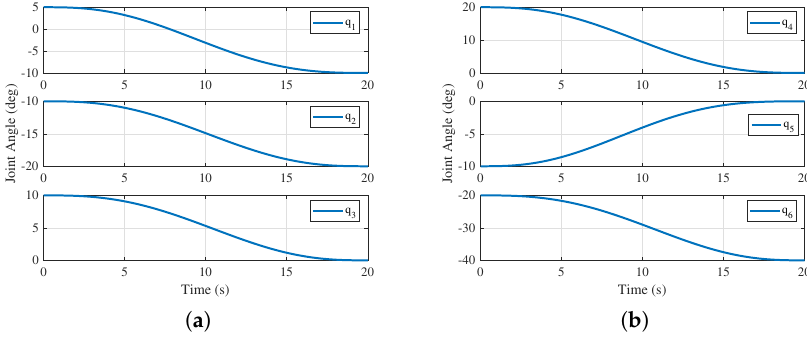
Figure 10. Angular variation curves of i th joint, where ( a ) i = 1, 2, 3, and ( b ) i = 4, 5, 6.